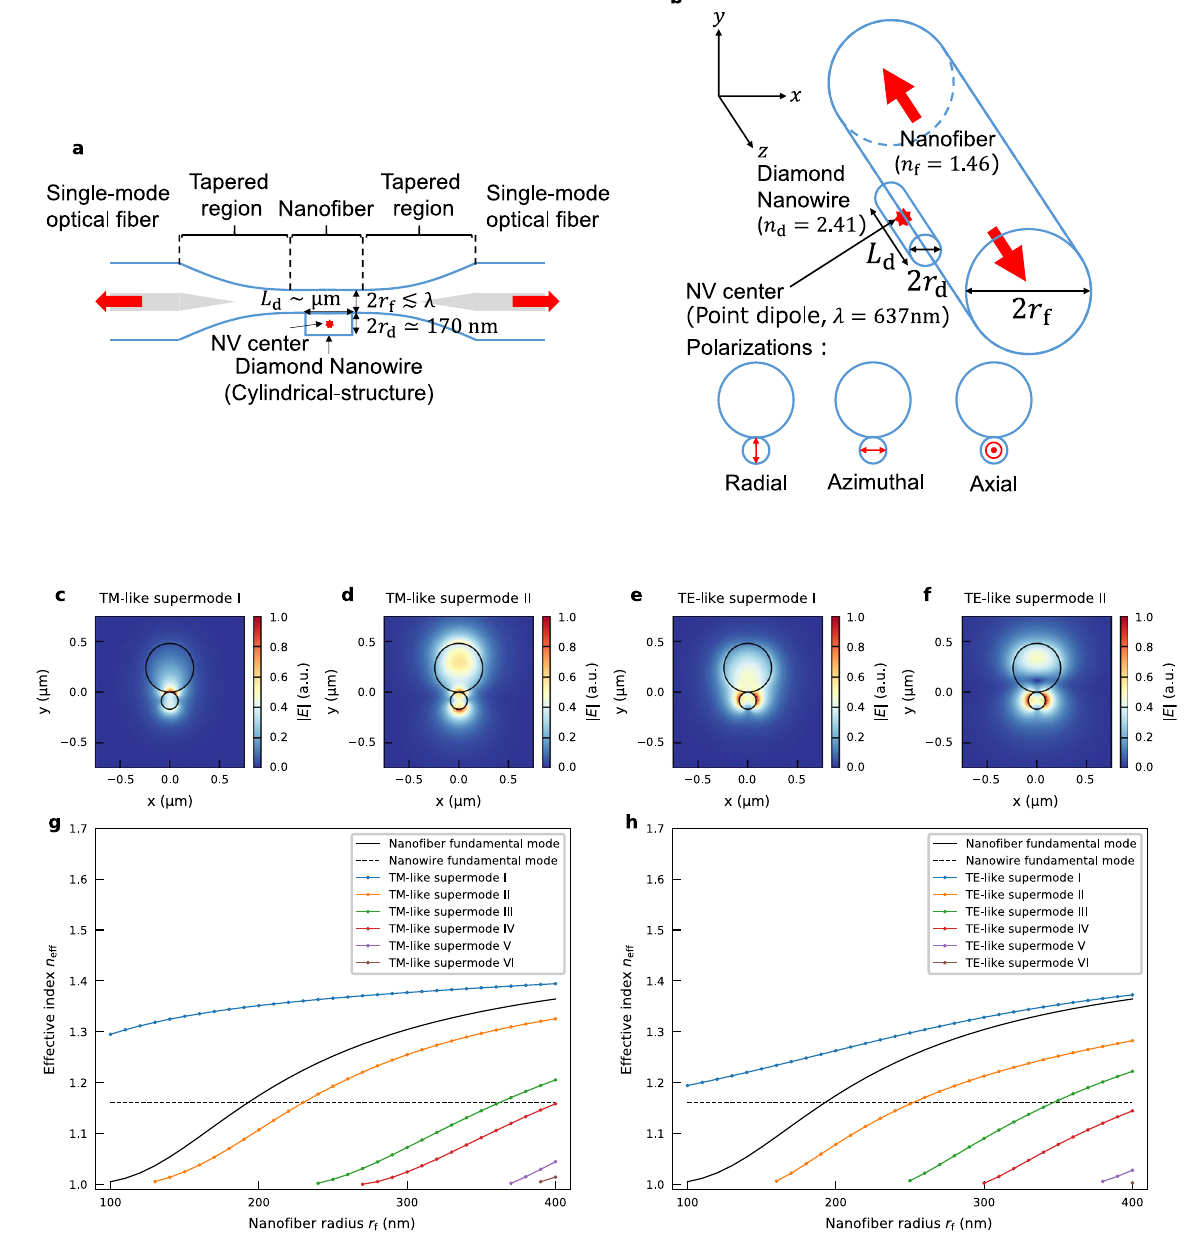
Figure 1. Coupling system between an optical nanofiber and a diamond nanowire. ( a ) Schematic of the proposed coupling system. ( b ) Geometry of numerical simulations. r f is the radius of the nanofiber, r d and L d are the radius and the length of the diamond nanowire, respectively. n f = 1.46 and n d = 2.14 are the refractive indices of silica and diamond, respectively. ( c – f ) Electric field distributions of two principal supermodes for the case of the nanofiber radius r f = 240 nm and the nanowire radius r f = 85 nm. The black solid lines represent the surfaces of the nanofiber and the diamond nanowire. ( g ), ( h ) Effective indices as a function of the nanofiber radius r f for TM-like supermodes and TE-like supermodes, respectively. The nanowire radius r d = 85 nm is fixed. The black solid and short dashed lines represent the effective indices of the uncoupled nanofiber and diamond nanowire fundamental modes,